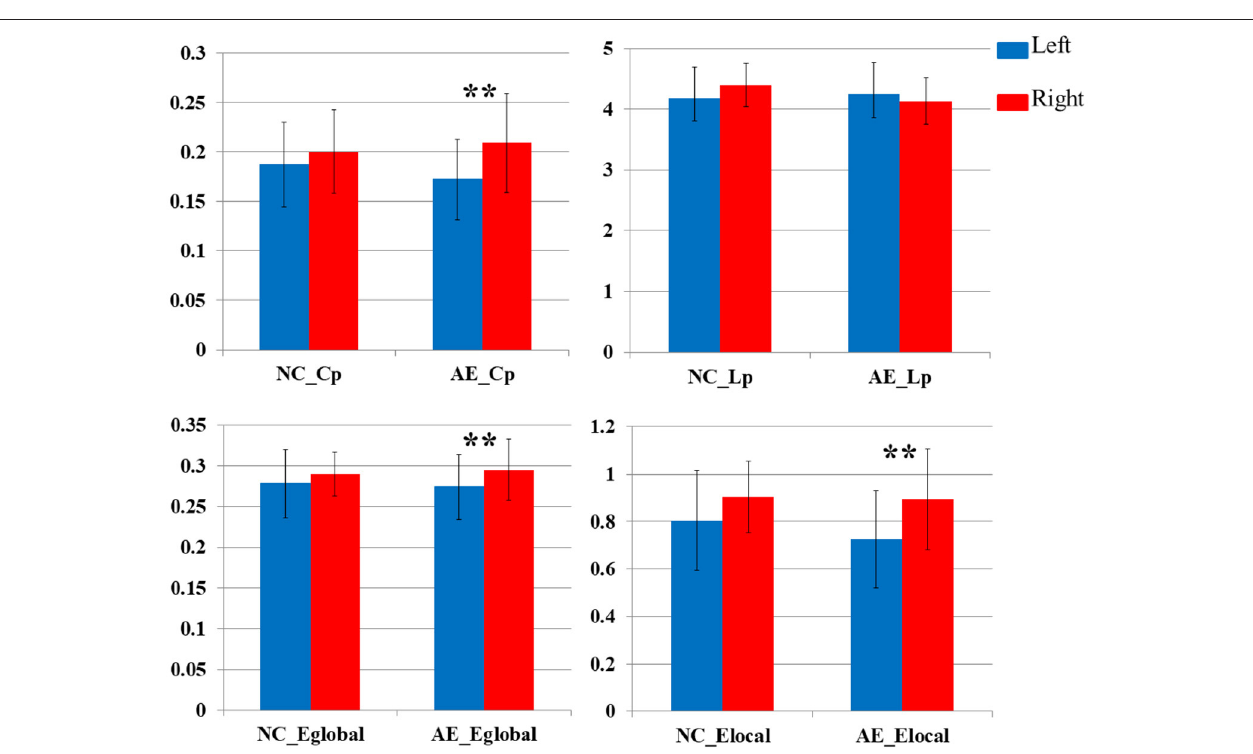
FIGURE 5 | Comparative analysis of network parameters between left and right hemispheres in patients with anti-NMDAR encephalitis and healthy controls (** P < 0.001).